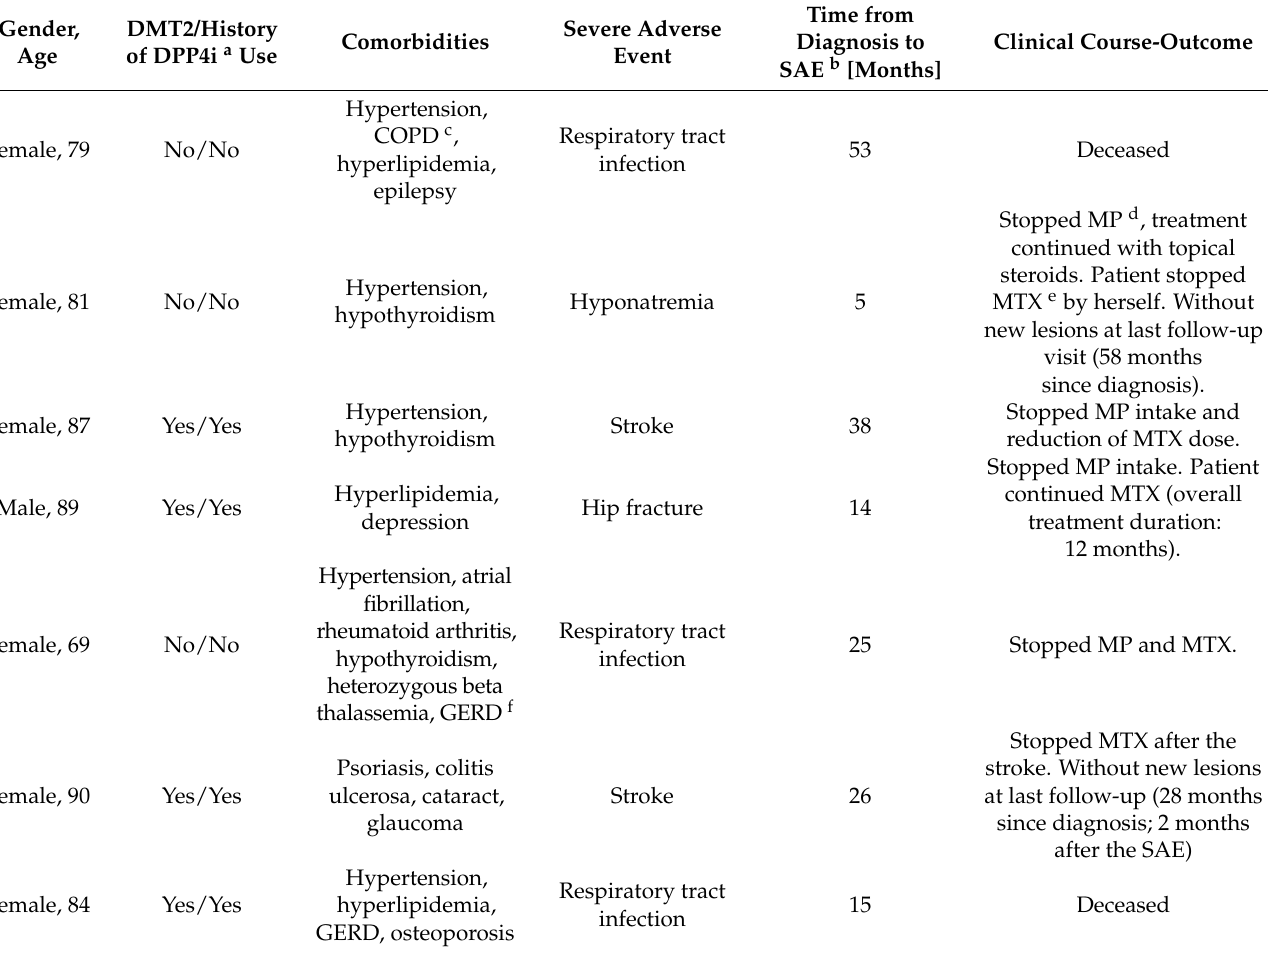
Table 4. Clinical data of patients with severe adverse events (SAE). Of note, all diabetes mellitus type 2 (DMT2) patients required insulin treatment because of glucocorticoid-induced deterioration of glycemic control.